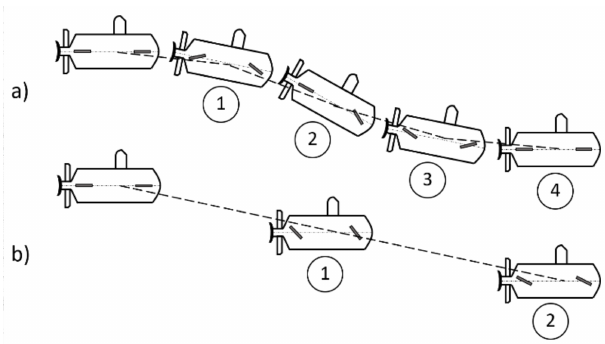
Figure 2. Hydroplanes tilting sequence for normal dynamic diving ( a ) and full dynamic diving ( b ). The diving path is illustrated by the dashed